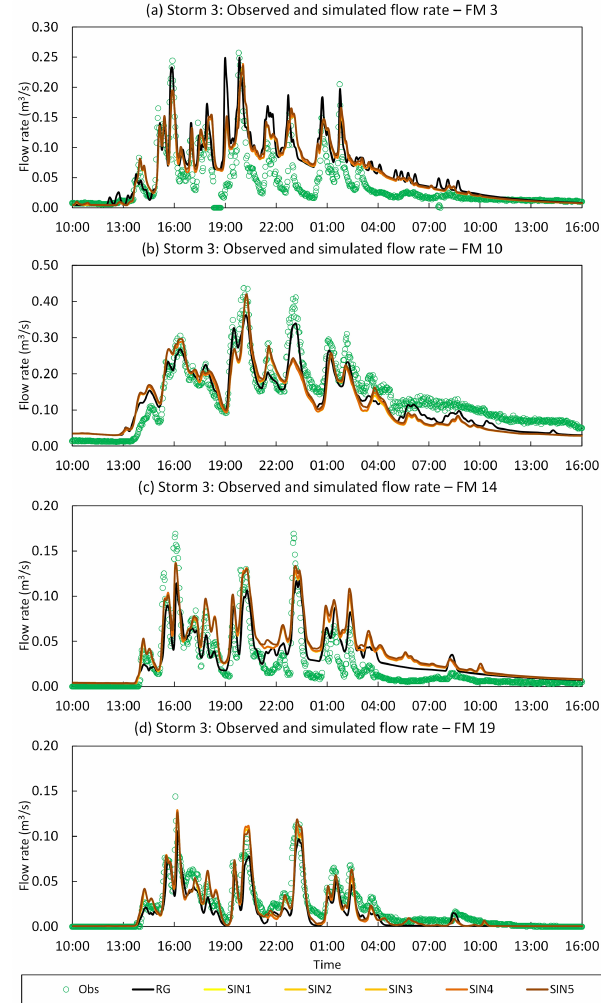
Figure 8. Observed flows vs. simulated flows with RG, RD, BK, BAY and SIN3 rainfall inputs at selected flow gauging sites of Por- tobello catchment during Storm 3. Selected gauging sites: FM3: up- stream end of the catchment (top panels); FM10: mid-stream area (bottom panels). The location of the selected monitoring sites is shown in Fig. 3.